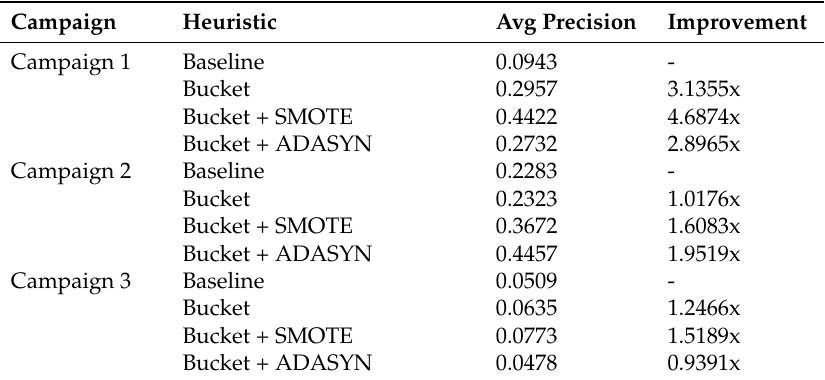
Table 2. Average precision (AP) score